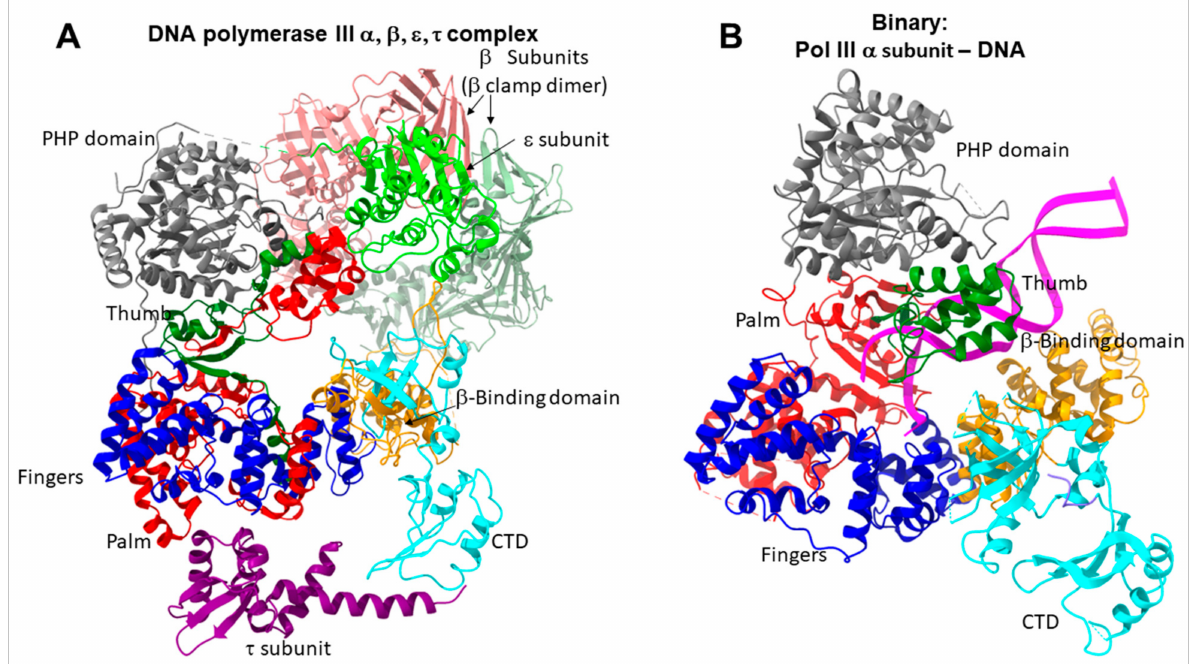
Figure 5. The cryo-EM structure of ( A ) the E. coli replicative DNA polymerase complex (DNA polymerase III alpha, beta, epsilon, tau) (PDB ID 5fku), and ( B ) the crystal structure of the alpha- subunit–DNA complex (PDB ID 3e0d). The holoenzyme is composed of 10 subunits ( α , β , ε , θ , δ (cid:48) , γ , τ , χ , and ψ ), together with the helicase DnaB and the RNA primase DnaG form the replisome. Pol III α contains six domains with different functions: the N-terminal Zn 2+ -dependent 3 (cid:48) -5 (cid:48) co- proofreading exonuclease polymerase and histidinol phosphatase (PHP) domain (gray); the catalytic palm domain (red); the incoming nucleotide-interacting fingers domain (blue); the nascent DNA gripping-thumb domain (green); the β -sliding clamp-binding domain (orange); and the CTD (cyan), which contains an oligonucleotide-binding OB fold and a possible external clamp-binding site at the extreme C terminus